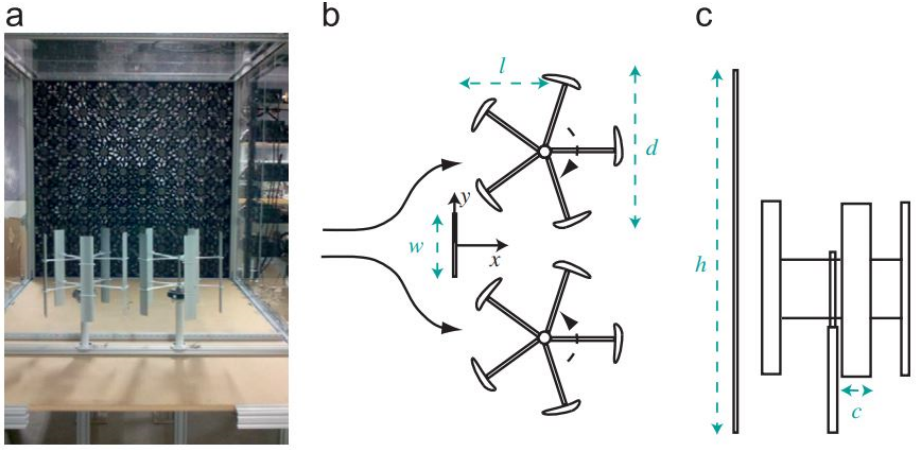
Figure 10. Wind deflector installed between two lift-based vertical axis wind turbines, ( a ) experimental setup in the wind tunnel, ( b ) top view, and ( c ) front view (adapted from [74]).